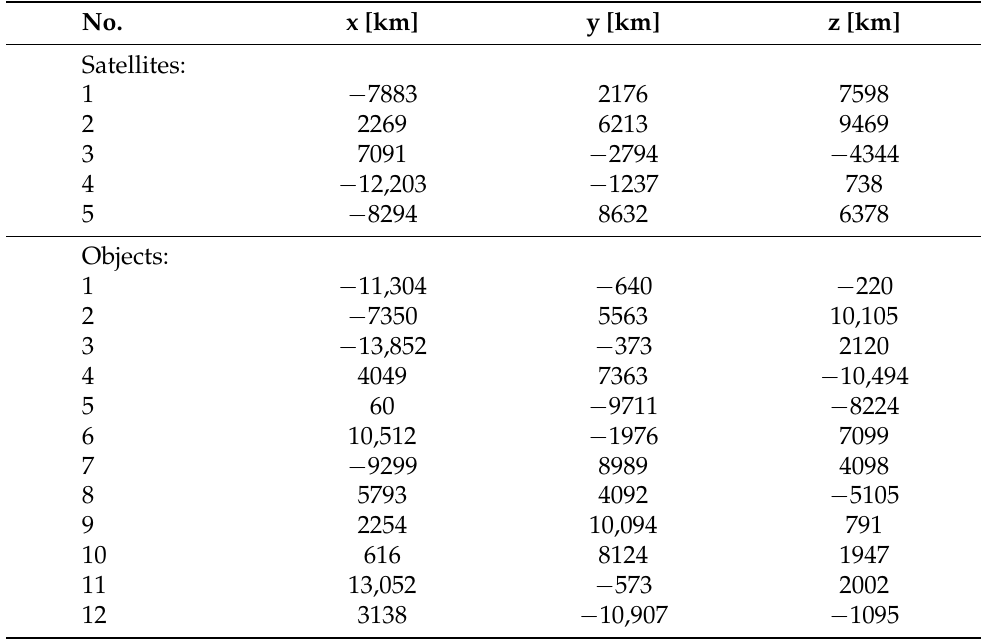
Table 1. Position coordinates of randomly generated 5 satellites and 12 objects in Earth-centered- Earth-fixed (ECEF) reference frame.